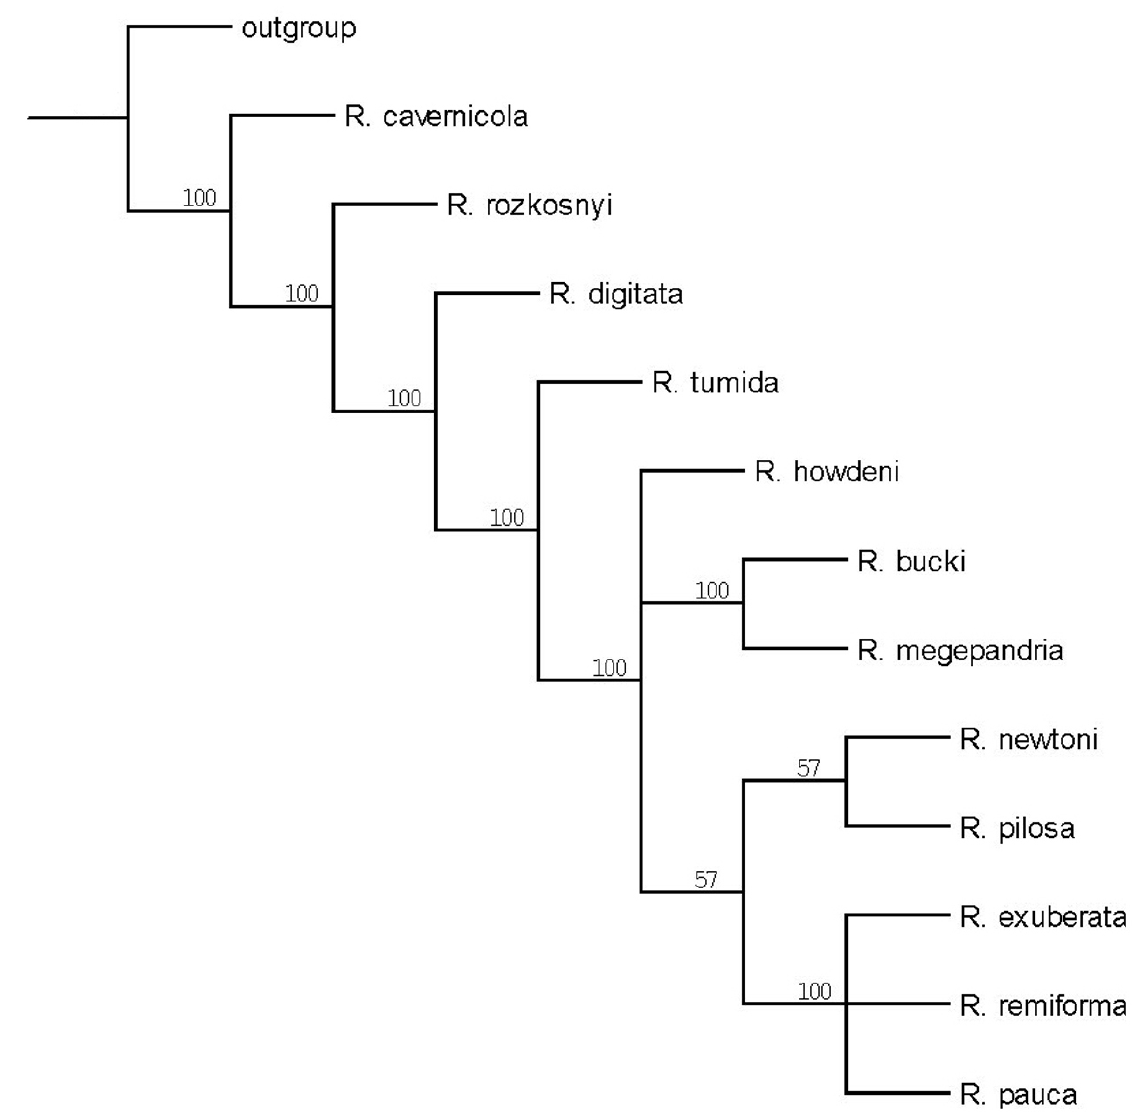
Fig. 6 . Majority Rules Consensus Tree from the 27 recovered trees retained from Traditional Search